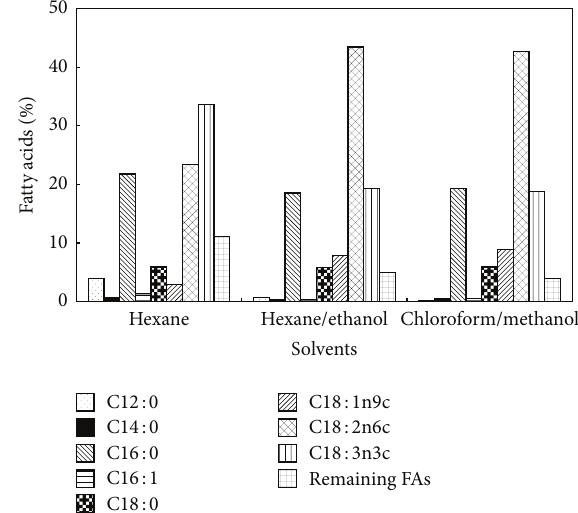
Figure 7: The effect of solvent mixture composition on the profile of fatty